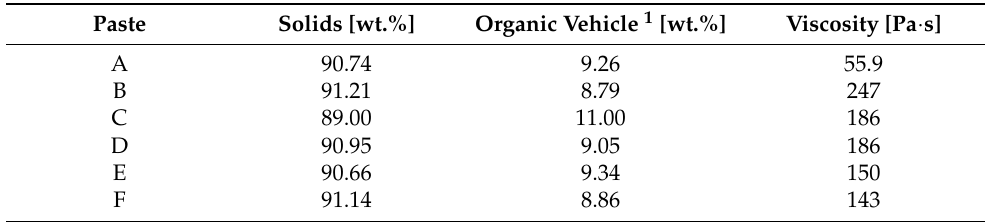
Table 1. Components and specifications of six silver pastes modified for Pattern Transfer Printing